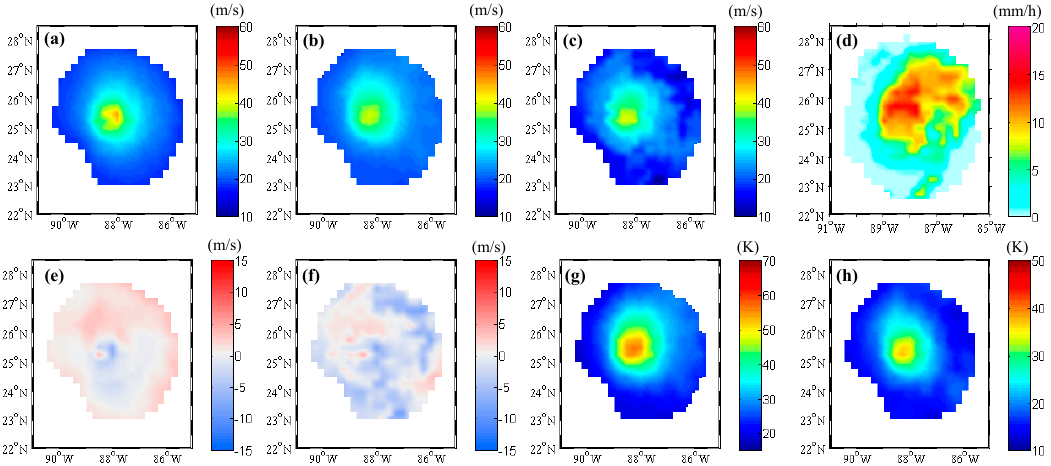
Figure 10. ( a ) H*wind wind speed of Rita on 22 September 2005, at 1330 UTC; ( b ) Retrieved wind speed of Rita with our new model on22 September 2005, at 1155 UTC; ( c ) RSS all-weather wind speed of Rita on 22 September 2005, at 1155 UTC; ( d ) RSS rain rate of Rita on 22 September 2005, at 1155 UTC; ( e ) The bias between H*wind and Retrieved wind speed with our new model; ( f ) The bias between H*wind and RSS all-weather wind speed; ( g ) W6H over Rita on 22 September 2005, at 1155 UTC; ( h ) W6V over Rita on 22 September 2005, at 1155 UTC.